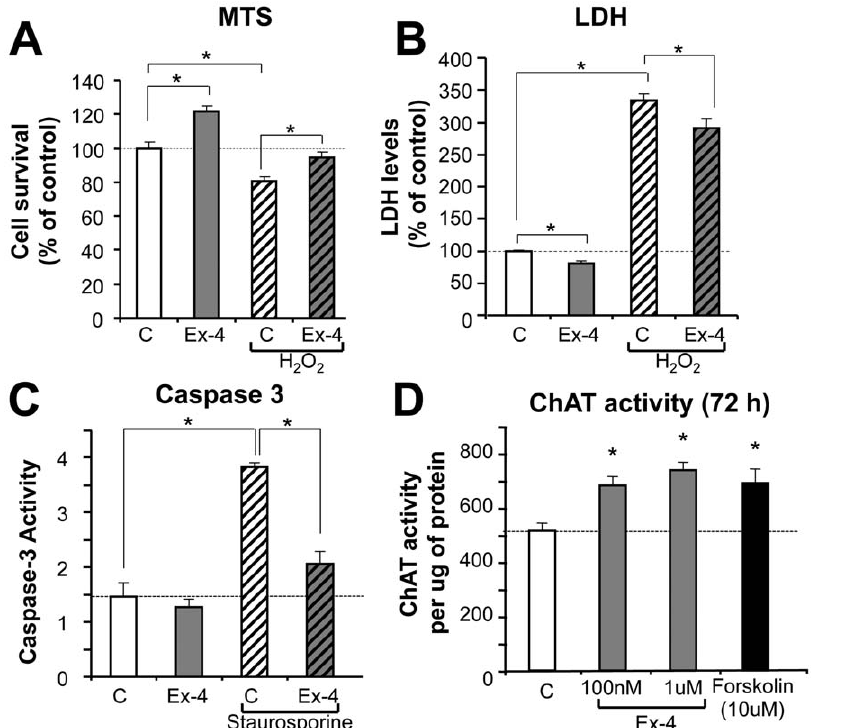
Figure 2. GLP-1R stimulation is neurotrophic and neuroprotective against oxidative stress and apoptosis in NSC19 cells. ( A – B ) Ex-4 is neurotrophic in NSC19 cells and pretreatment with Ex-4 protects cells from H 2 O 2 -induced cell death. Cells were pretreated with 100 nM Ex-4 for 4 h, and then exposed to 1.5 mM H 2 O 2 . Cell viability was assessed by MTS ( A ) after 24 h or LDH ( B ) after 48 h (C: vehicle-treated control; Ex-4: exendin-4 with and without H 2 O 2 , n $ 6, * p , 0.05). ( C ) Ex-4 pretreatment inhibits apoptosis in NSC19 cells. Exposure to 100 nM staurosporine significantly induced caspase-3 activity in NSC19 cells, pretreatment with 100 nM Ex-4 for 24 h reduced elevated caspase-3 activity in these cells (C: vehicle-treated control; Ex-4: exendin-4 with and without staurosporine, n=3, * p , 0.05). (D ) Ex-4 elevates choline acetyltransferase (ChAT) activity in NSC 19 cells. NSC19 cells plated on 24-well plates were treated with 100 nM or 1 m M of Ex-4 as well as 10 m M forskolin for 72 h. ChAT activity was measured in cell lysates and normalized by protein content (n=3, * p ,